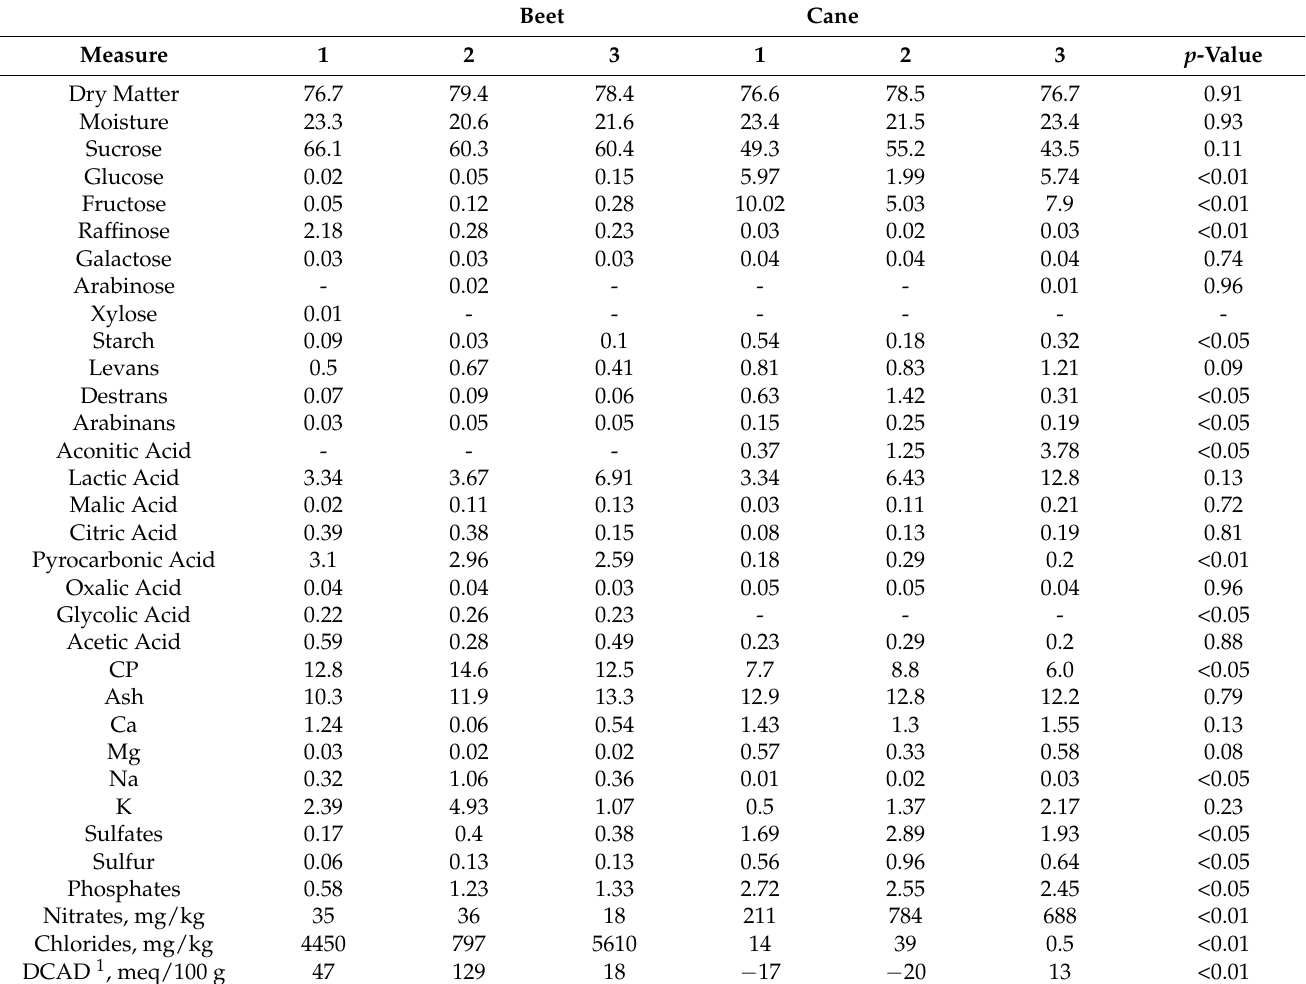
Table 1. Molasses composition. Values are expressed as % DM unless differently specified. Beet